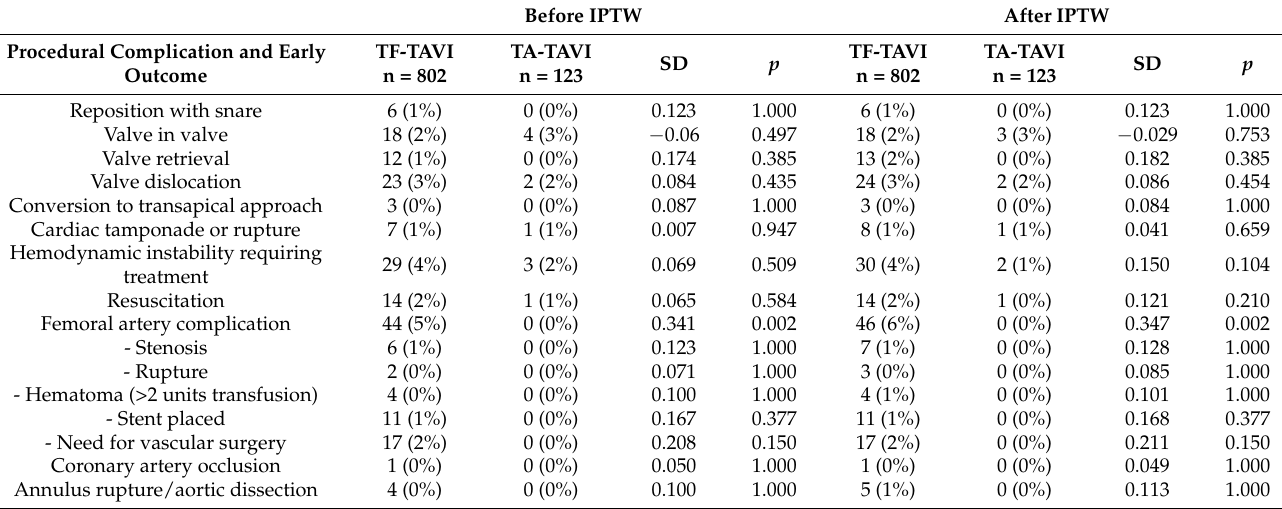
Table 3. Procedural complication and early